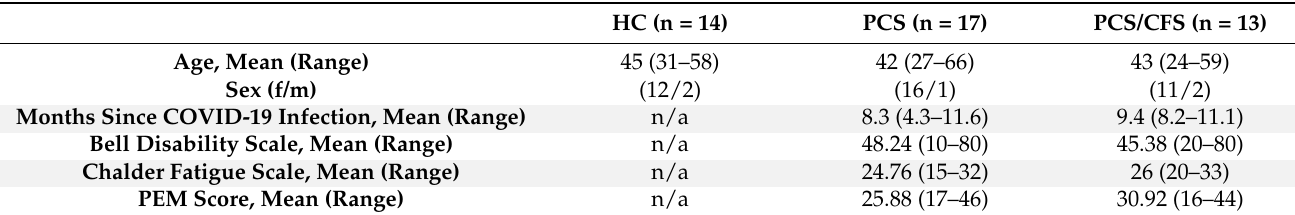
Table 1. Patient and control group